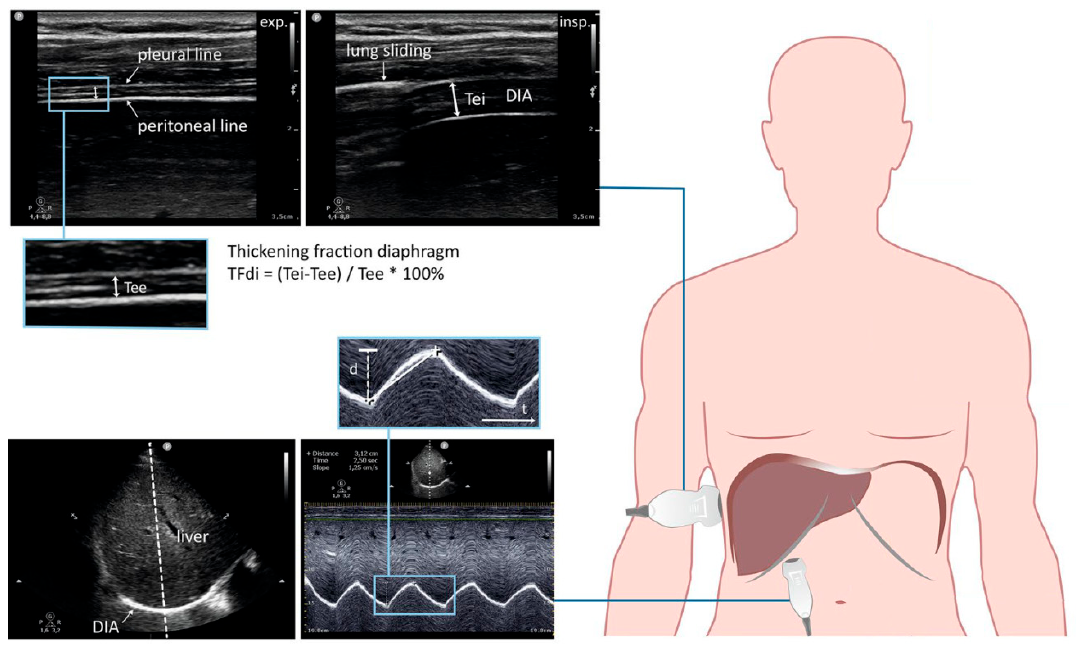
Figure 1. Clinical application of diaphragm muscle ultrasound (Figure modified according to: Tuinman et al. [14], Figure 1; p. 596).